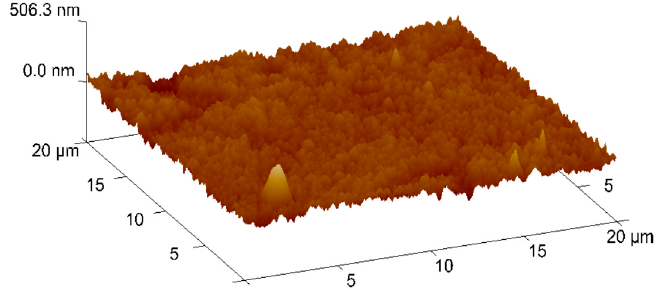
Figure 7. SEM top view of the TiAlN film surface.